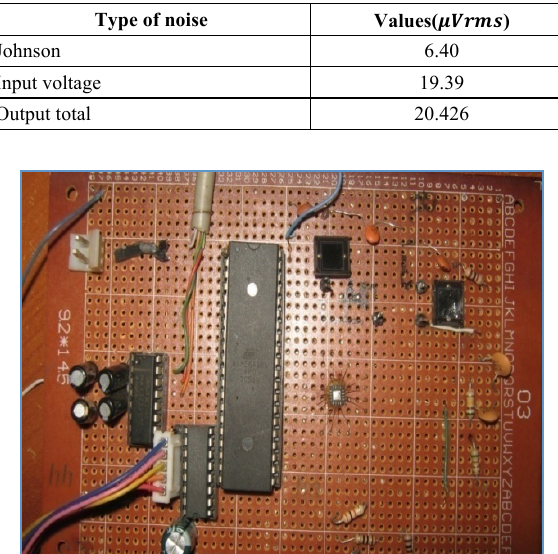
Figure 6. Printed circuit board of the transimpedance amplifier